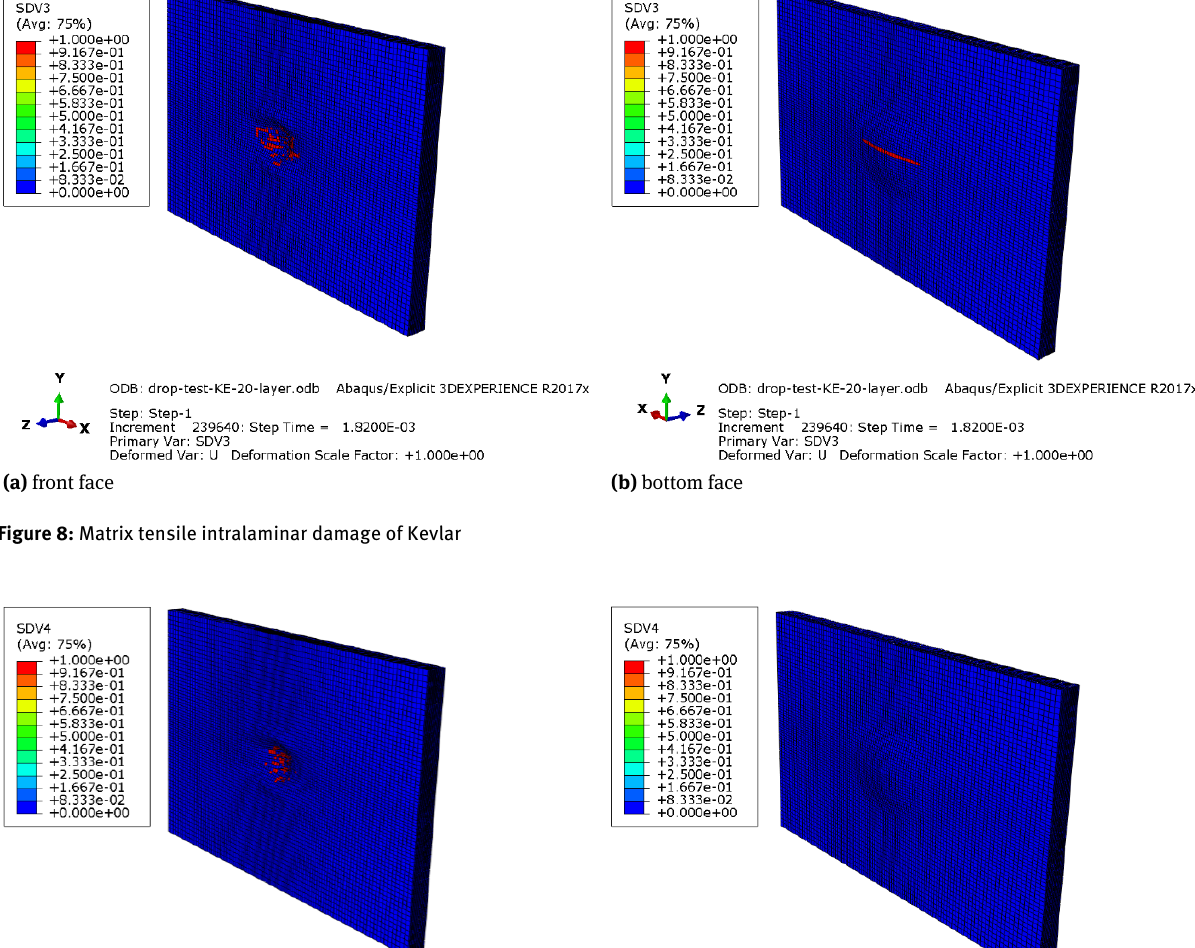
tension and compression stresses, the matrix damage hap- pens in the front and the backplate faces close to impact the region. The numerical model predicted failure modes as illustrated in Figures 8 and 9, where the SDV3 and SDV4 are matrix damage tension and matrix damage compression respectively. It can be seen that the numerical results have a good prediction of failure behavior compared with the experimental